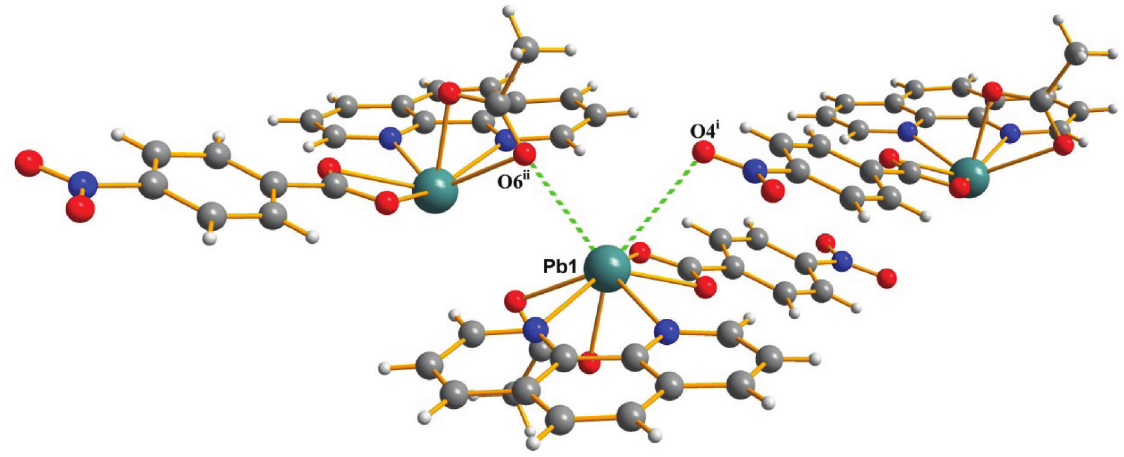
Figure 4: Secondary Pb···O interaction shown as green dashed lines. Symmetry code: (i): 2- x , 1- y , 1- z ; (ii): 2- x , 2- y , 1- z